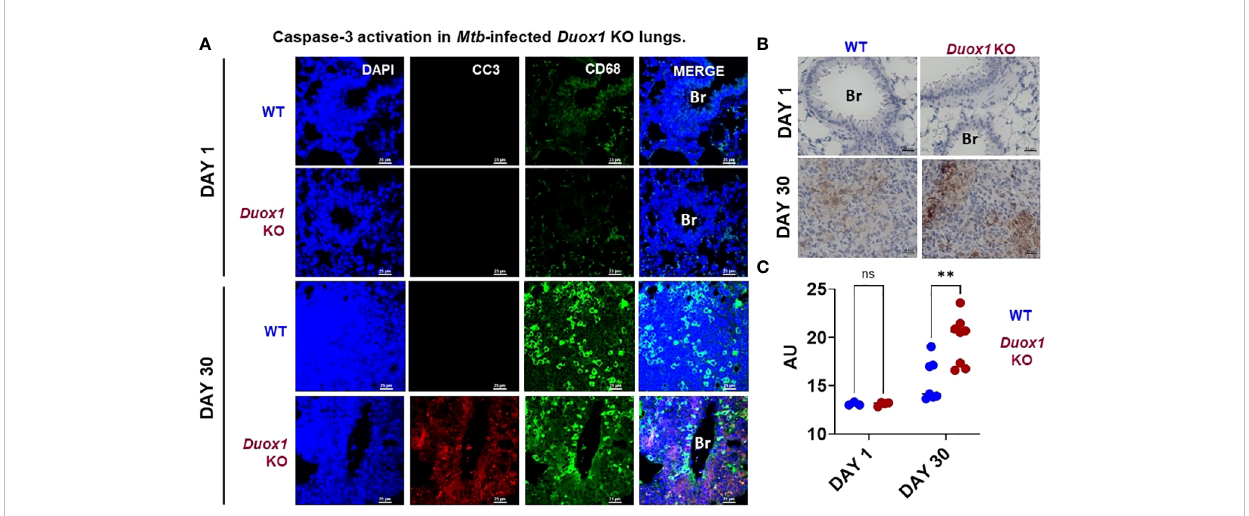
FIGURE 8 Caspase-3 activation in Mtb -infected Duox1 KO lungs. Mtb -infected lungs of WT and Duox1 KO mice were harvested and fi xed at 1 or 30 day(s) post-infection. (A) Representative immuno fl uorescence staining of cleaved caspase-3 (CC3, red), CD68 (macrophages, green) and DAPI (DNA, blue). Scale bar: 25 µm). (B) Representative results of cleaved caspase-3 immunohistochemistry images at 1 (n=3 per genotype) and 30 days post-infection (n=8 per genotype). Scale bar indicates 25 µm. (C) Comparative non-stochiometric DAB signal quanti fi cation with ImageJ shows that the